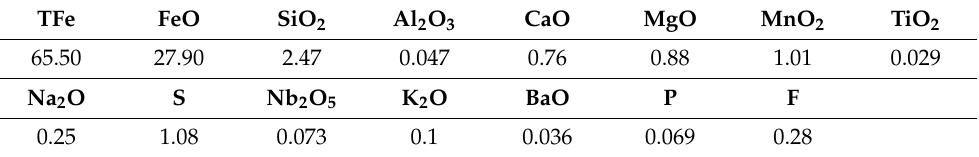
Table A1. The chemical composition of magnetic separation iron concentrate